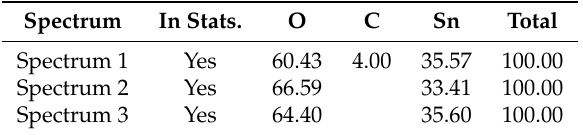
Table 2. EDX spectra showing the atomic percentages of Sn and oxygen